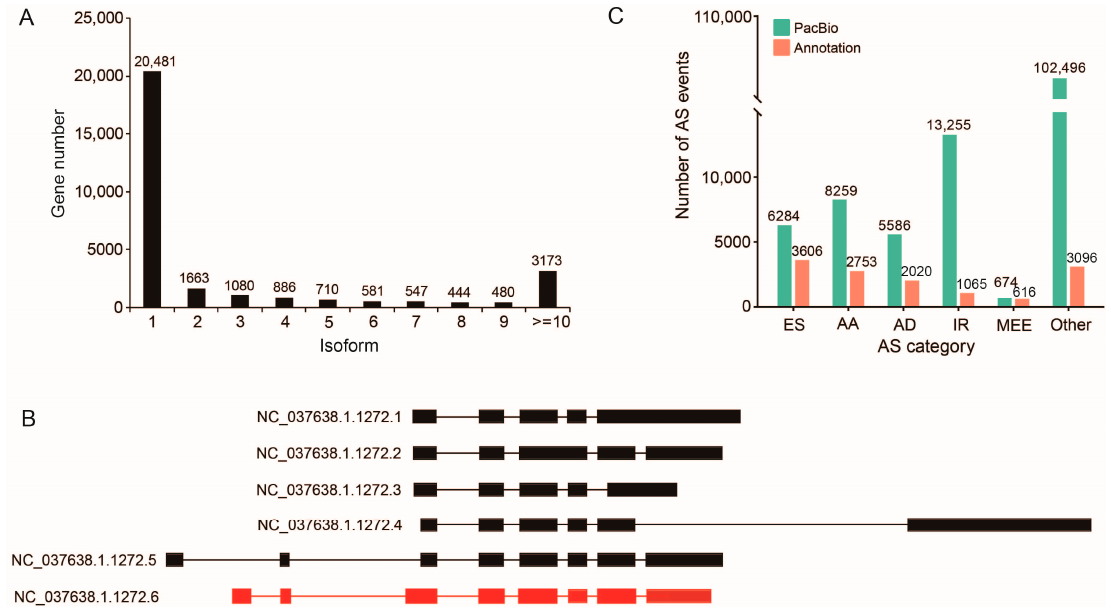
Figure 3. The alternative splicing events identified from PacBio honey bee transcriptome. ( A ) Distribution of splice isoforms of genes. ( B ) The exon/intron structure of the six isoforms of the Mob3 gene. The filled boxes represent exons and lines represtent introns. The isoform in red was obtained by genome annotation. ( C ) The comparison of each alternative splicing type between this PacBio data and the NCBI reference transcript set.